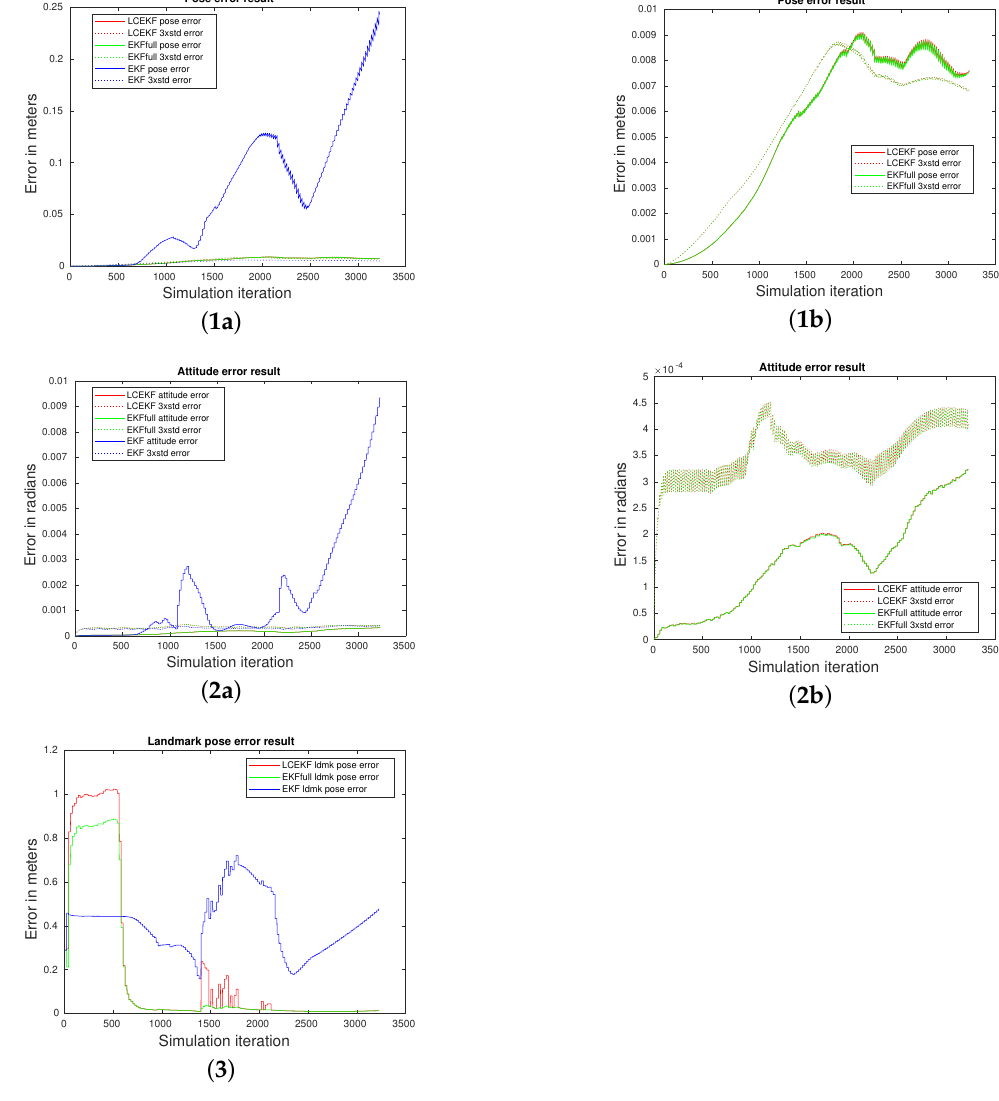
Figure 8. SLAM with discontinuous noise (Case iv): methods’ comparison. Figures ( 1a ) and ( 2a ) represent the MSE of the pose and attitude estimation over 100 executions for the three methods. As the EKF results hide the two other, the same results without the EKF are presented in figures ( 1b ) and ( 2b ). Full lines are the mean of the estimation, and dotted lines represent the 3 sigma value. Figure ( 3 ) represents the MSE of the landmark convergence during the